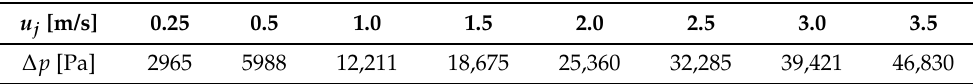
Table 1. Pressure drop in microchannels of height, width and length equal to 0.5, 0.1 and 10 mm for different microchannel average